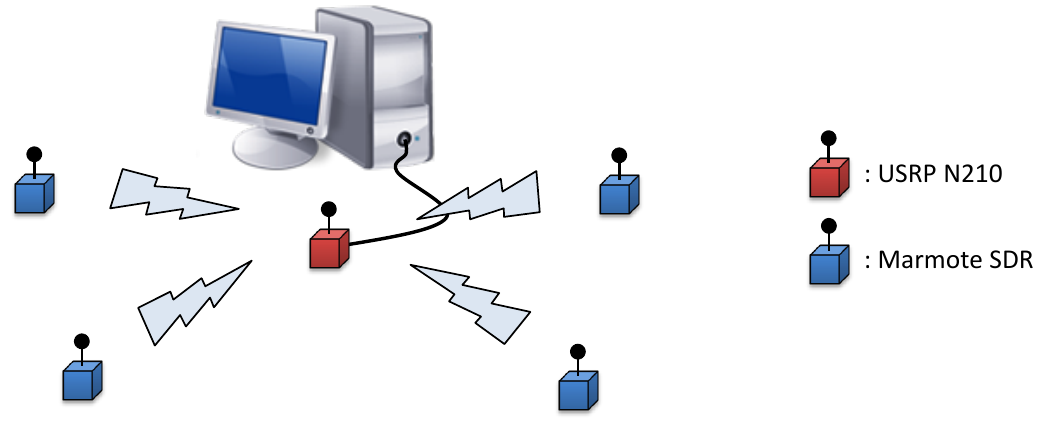
Figure 4. Measurement setup with four Marmote SDR sensor nodes (transmitters), a USRP N210 and desktop computer base station (receiver).